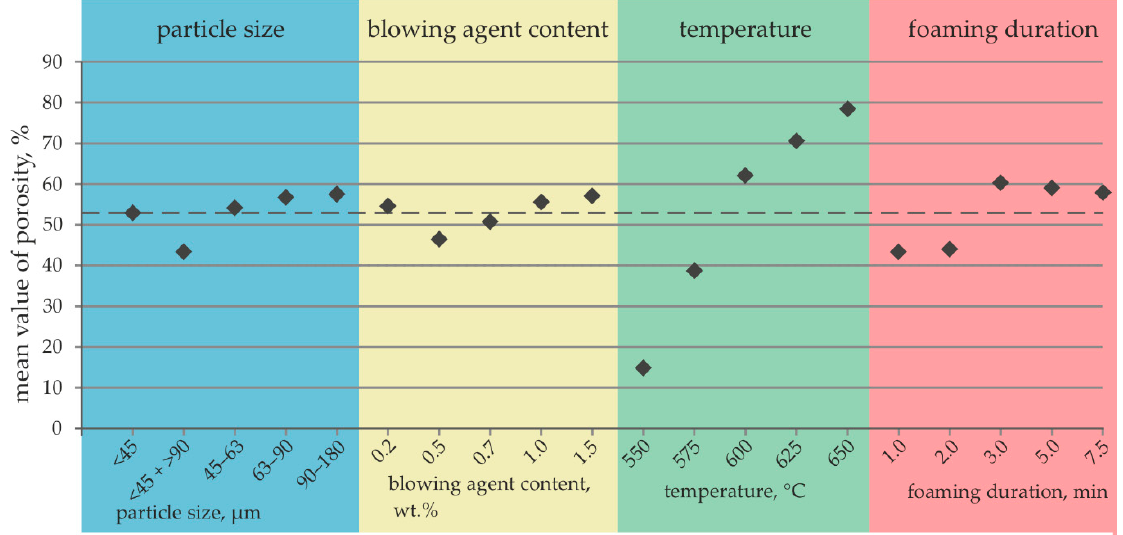
Figure 14. Section from the XRM image of sample no. 11 with foaming temperature of 600 °C, foaming duration of 7.5 min, 0.2 wt.% TiH 2 showing intact cell walls.